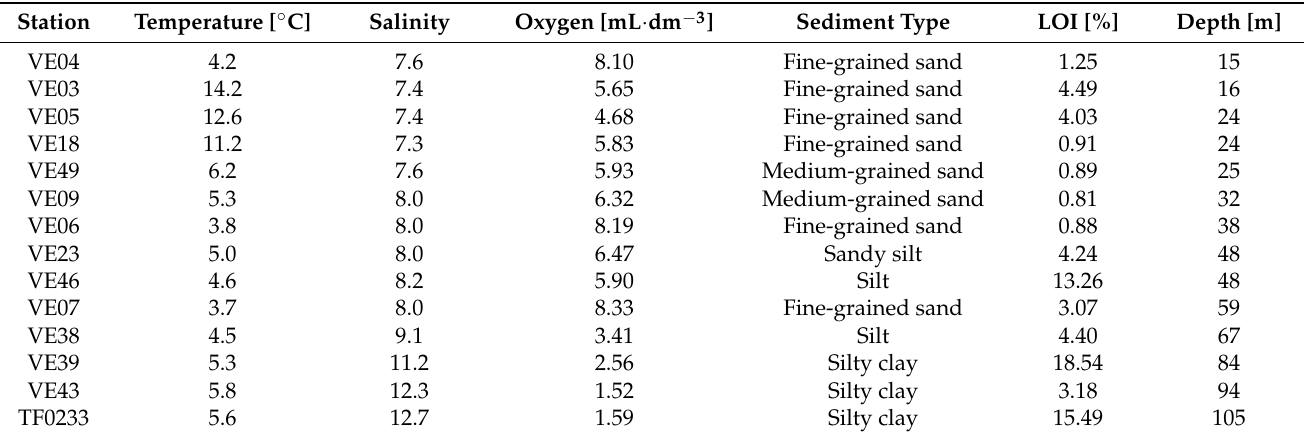
Table 1. Values of sediment characteristics and environmental variables measured in the bottom waters at research